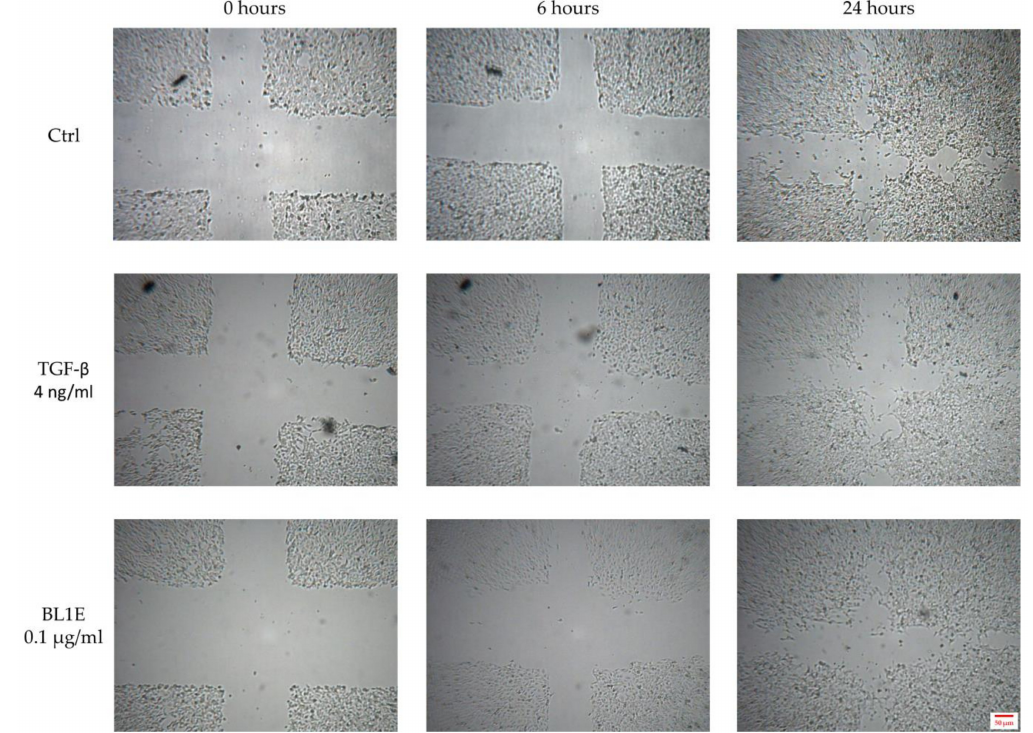
Figure 6. In vitro HaCaT wound healing of the untreated control (up), the positive control (center) and BL1E 0.1 µ g/mL (down) at 0 (left), 6 (center) and 24 (right) hours after